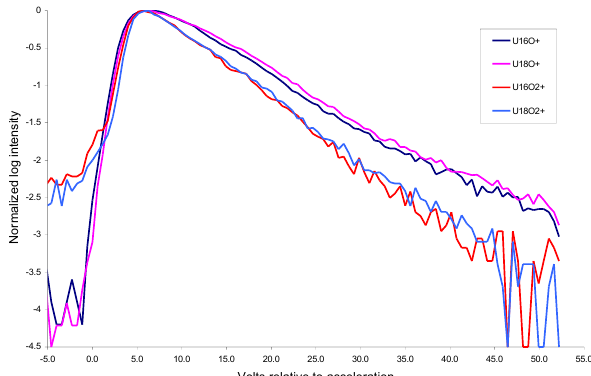
Figure 9. Normalized energy plots for the UO + and UO + species 2 U 16 O + , U 18 O + , U 16 O + , and U 18 O + . Energy is relative to 10kV 2 2 extraction potential. Peak intensities are normalized and plotted in log scale. Note that the UO 2 ions have a population with negative initial energy not present in the UO species.